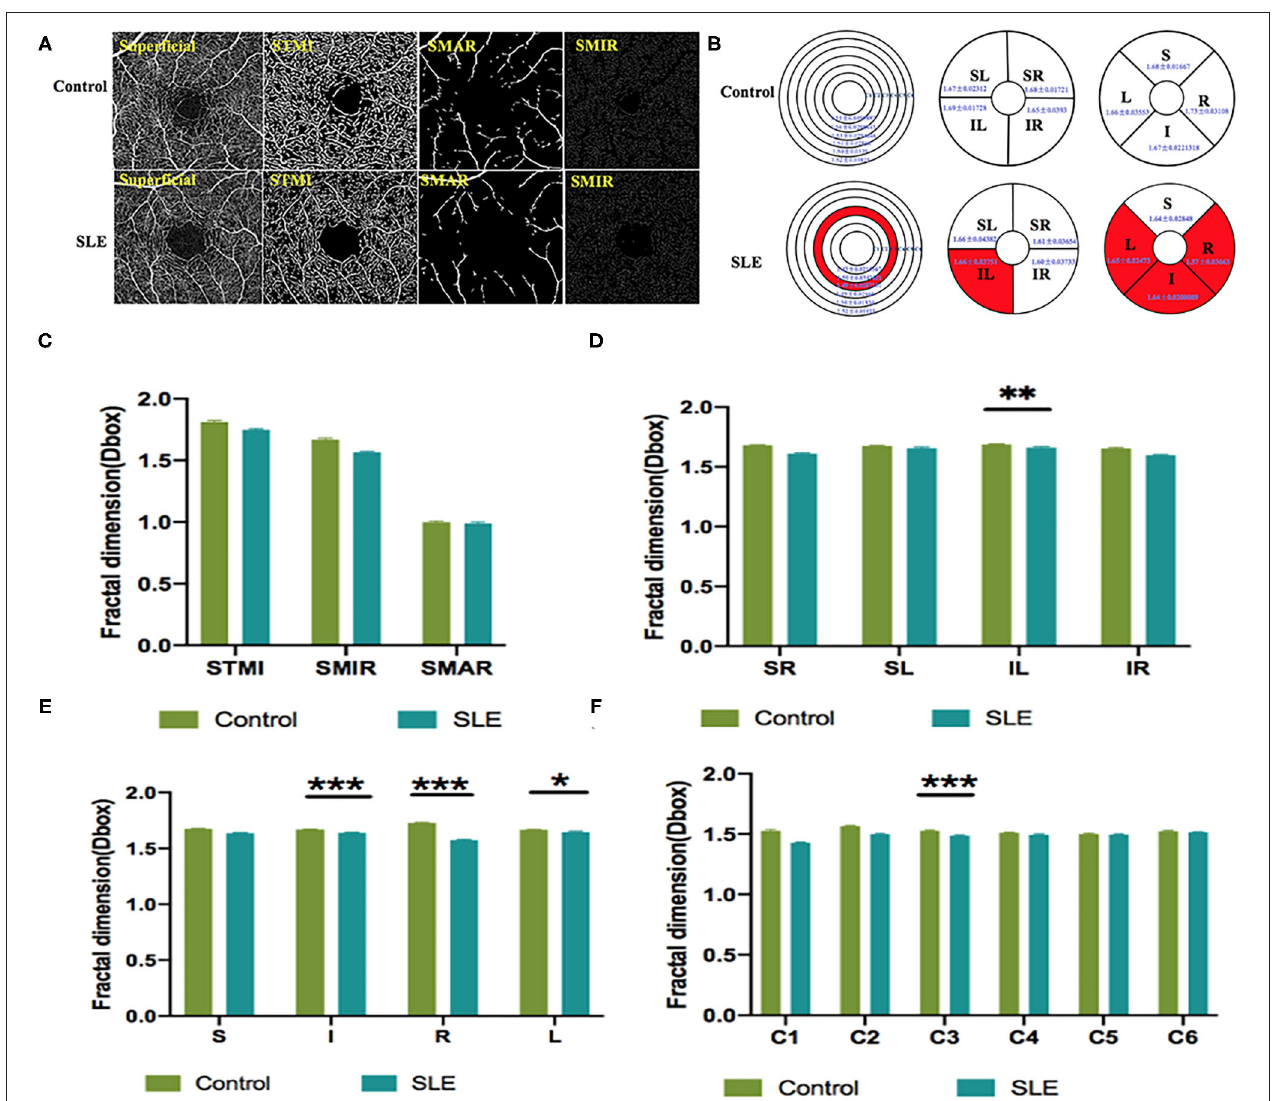
FIGURE 3 | The OCTA images and vessel density analysis of superficial retinal layer of control and SLE groups. (A) Superficial retinal vessel density map. (B) Results of superficial retinal vascular density in different regions of normal group and SLE group (MD ± SD); (C–F) Results of superficial retinal vascular density analysis in normal and SLE groups. STMI, Superficial total microvascular; SMAR, Superficial macrovascular; SMIR, superficial microvascular; SLE, Systemic lupus erythematosus; L, left; R, right; S, superior; I, inferior; IL, inferior left; IR, inferior right; SL, superior left; SR, superior right. * P < 0.05; ** P < 0.01; *** P <